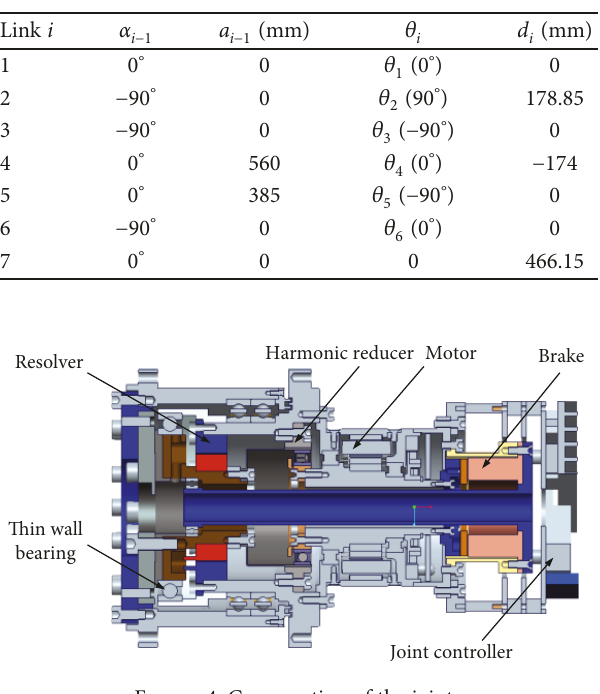
Figure 4: Cross section of the joint.